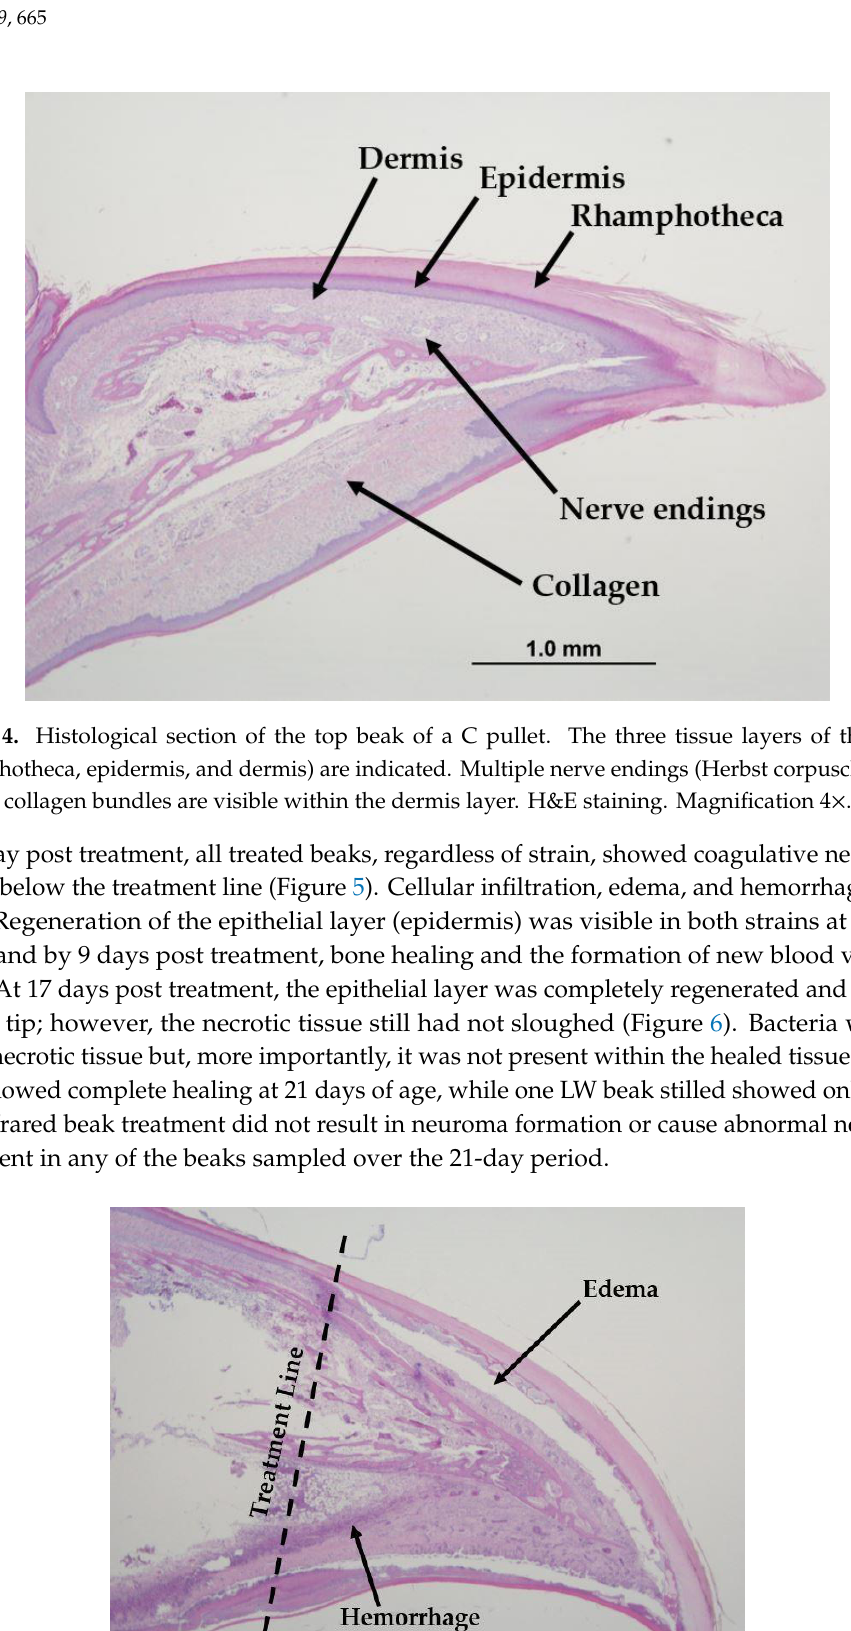
Figure 3. Beak healing scores for infrared beak treated Lohmann Brown-Lite (LB) and Lohmann LSL- Lite (LW) pullets compared to sham treated control (C) pullets (scores identical for C pullets from each strain). Descriptions for histological scores are provided in Table 2. Each marker represents a single bird. Dashes on the lines represent the median score.